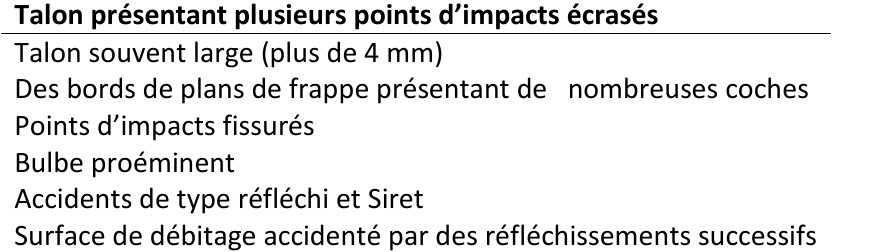
Tableau 2. Stigmates de percussion au percuteur de silex (d’après Biard & Riche sous presse ). Table 2. Stigmas of flint percussion (after Biard & Riche in press